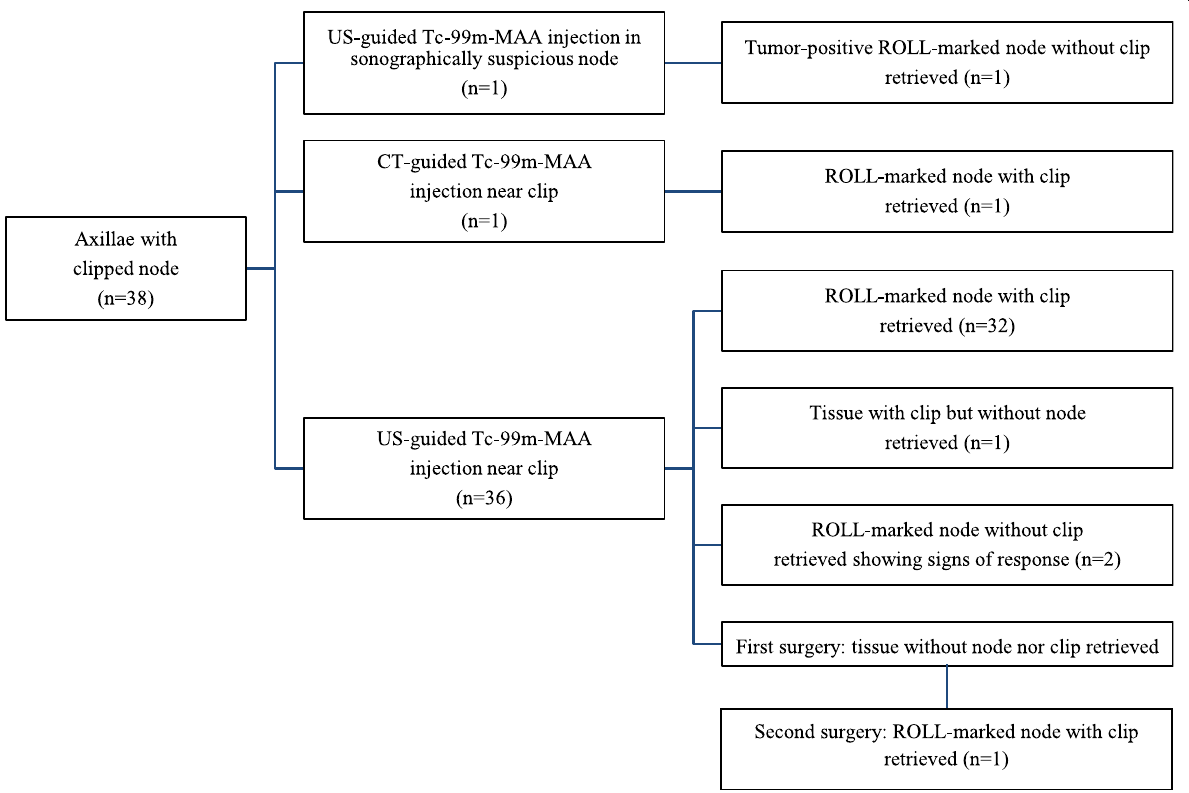
Fig. 2 Flowchart of 38 ROLL-node procedures with surgical outcomes. Tc-99m-MAA technetium-99m-labeled macroaggregated albumin, ROLL Radioguided occult lesion localization, US ultrasound, CT computed tomography